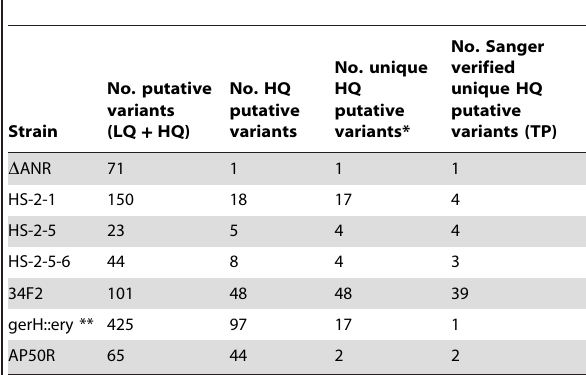
Table 3. Determination of putative variants in the genomes sequenced in this